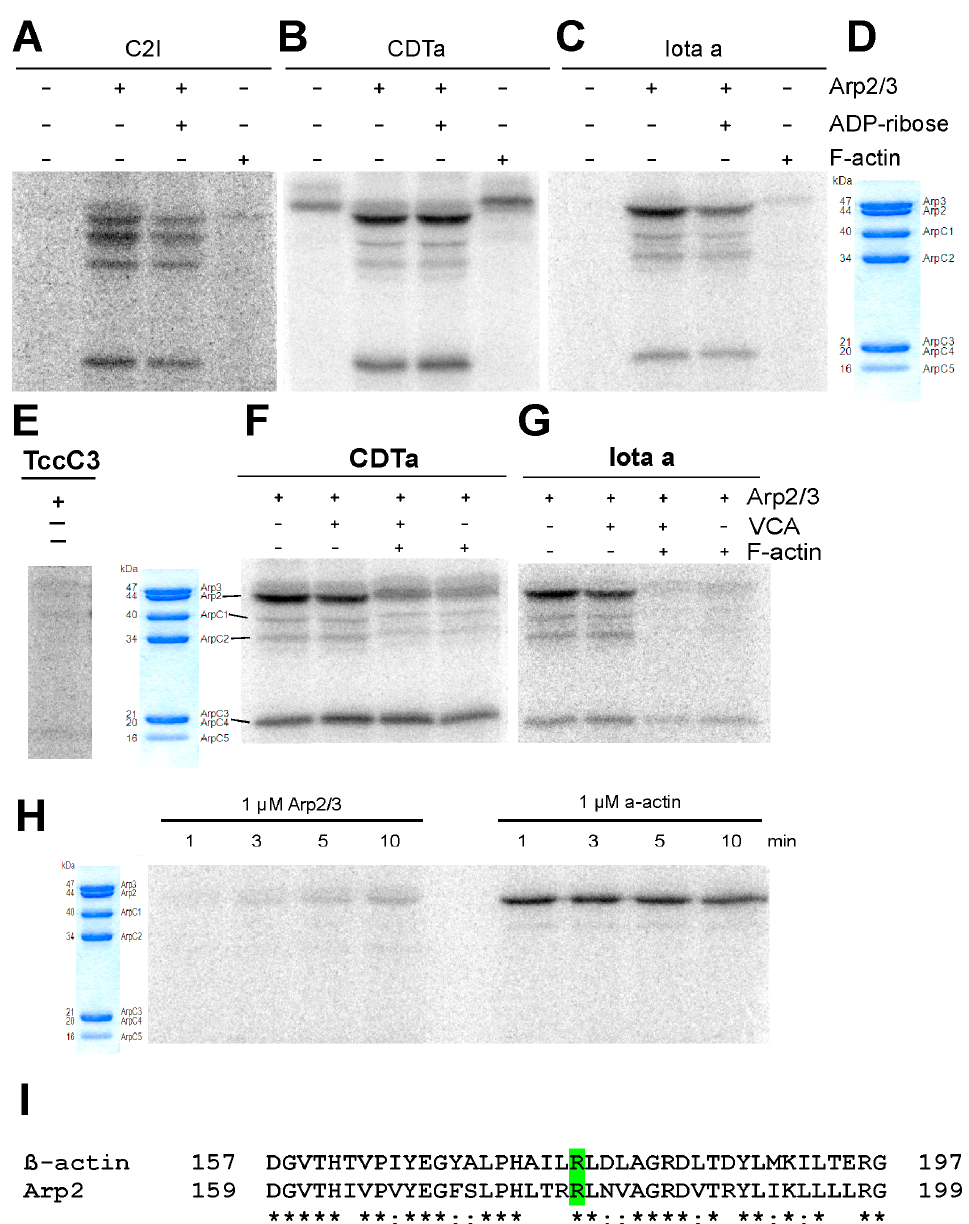
Figure 1. Autoradiographs using 32 P-NAD to show ADP-ribosylation of Arp/3 complex components. by ( A ) CD1 ( C. botulinum ), ( B ) CDTa component ( C. difficile ), and ( C ) Iota-a toxin ( C. perfringens ). ( D ) Corresponding Coomassie blue stained gel (12.5% polyacrylamide) showing the components and their molecular mass of Arp2/3 complex purified from A. castellani . Note that Arp2 is most selectively ADP-ribosylated by CDTa and Iota-a toxin. Only the effect of Iota-a toxin is slightly inhibited by ADP-ribose. Only CDTa is auto-ADP-ribosyl at ed (4th lane in B). None of the toxins appears to ADP-ribosylate F-©in. ( E ) TccC3 ( Photorhabdus luminescence ) shows no ADP-ribosylation of any Arp2/3 complex component. ( F,G ) ADP-ribosylation by CDTa and Iota-a toxin is not modified by the presence of the VCA peptide but inhibited by F-actin. Incubation time in ( A – G ) was 90 min at 25 °C. ( H ) Time dependence of ADP-ribosylation of Arp2 of Arp2/3 complex and monomeric skeletal muscle G-actin by the CDTa component. ( I ) Gives the aligned sequences of Acanthamoeba and mammalian Arp2/3 complex around the sites of ADP-ribosylation (for details see text). (*) Identical residues and green highlighted are the ADP-ribosylated arginines.